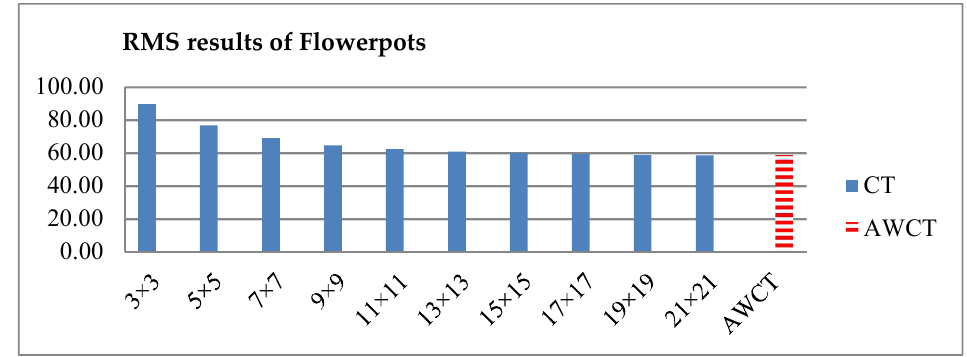
Figure 16. RMS comparison results of Flowerpots between AWCT and CT.